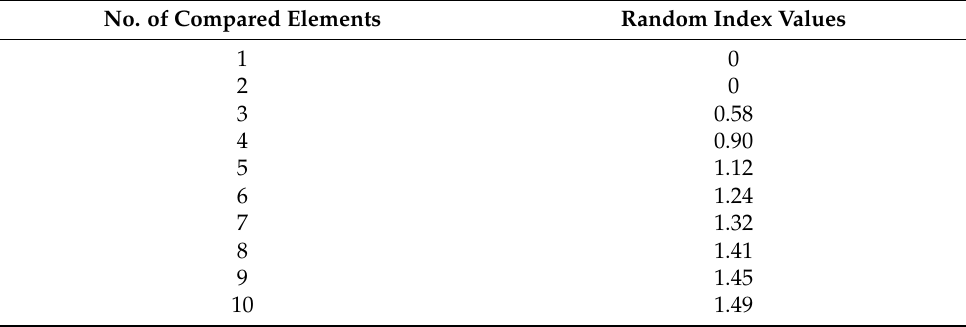
Table 2. Random index values, as addressed by Saaty